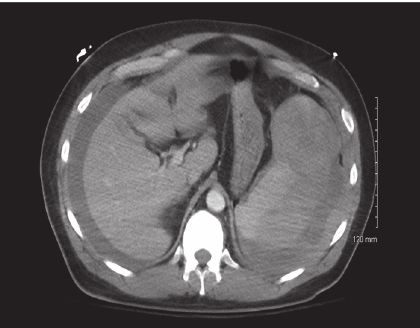
Figure 2: Initial computed tomography scan (CT) of the abdomen showing perihepatic and perisplenic fluid, and the lateral margin of the spleen indistinct with low density areas, concerning for splenic injury or rupture.